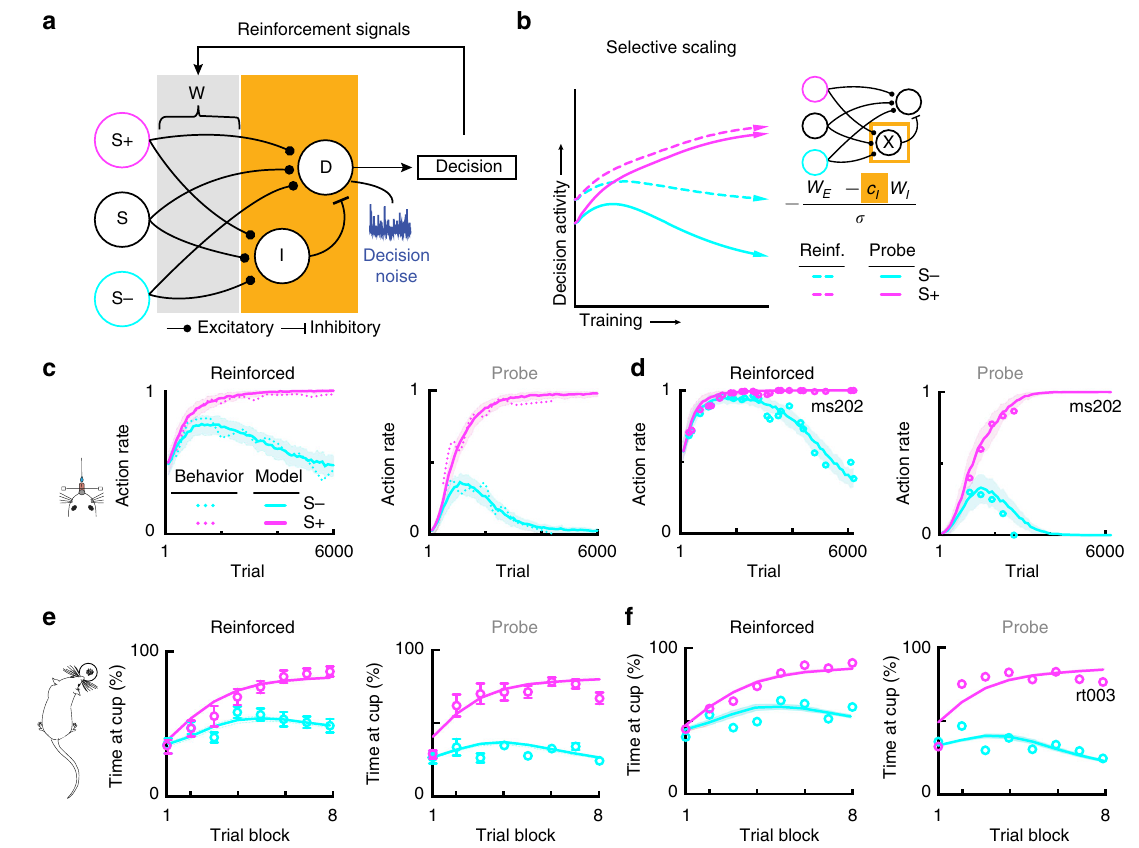
Fig. 3 Contextual scaling in a reinforcement learning model. a Schematic of the model, which implements reinforcement-driven learning of stimulus-action associations, with a readout function that can be contextually modulated. The model simultaneously captures reinforced and probe learning trajectories by dissociating between reward-driven plasticity representing task acquisition (gray, reinforcement signals) and context-dependent changes in expression (orange, contextual scaling) of the learned values. Plastic synapses between sensory and decision-making populations represent stimulus-action values, and their weights are only updated during reinforced trials (gray shading, reinforcement signals). Actions are generated by the decision-making (D and I) units (orange shading), which read out the sensory input fi ltered through the synaptic weight matrix (W). The decision unit ’ s (D) activity determines the probability that the model will respond. The parameters of the readout units (orange shading) are modulated between the reinforced and the probe contexts, either via selective scaling of inhibition and excitation, noise modulation, or threshold changes (see Supplementary Fig. 4). b Left: illustration of the effects of selective scaling of inhibition on D ’ s activity. Decision activity represents the net input to the decision-making unit, i.e., the difference between the values of the go and no-go actions, for the target (magenta) and foil (cyan) tone over the course of learning. Solid and dashed lines, respectively, indicate probe and reinforced context (inhibition scaling c I : 0.52). Right: schematic of the contextually modulated model via inhibitory scaling, and a description of how inhibitory scaling is mathematically implemented. The net output of the model is proportional to the excitatory weights (W E ) minus the inhibitory weights (W I ). In the probe context, the inhibitory weights are multiplied by a scalar factor (C I , orange). Throughout panels a-b, orange highlights the context-dependent parameters. c Comparisons between average mouse behavioral data ( n = 7 mice) and fi ts of the inhibitory scaling model for the two contexts. d same as c but for the learning trajectory of one individual mouse. e , f , same as c , d , but for rat behavioral data ( e : n = 6 rats; f : rat